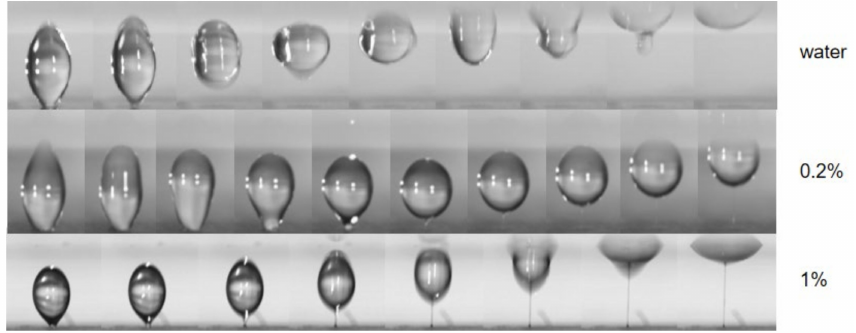
Figure 7. The sequence of water, 0.2% PEO aqueous solution and 1% PEO aqueous solution droplet taking off from superhydrophobic substrate. The water droplet shows no filament formation, while PEO droplets do.